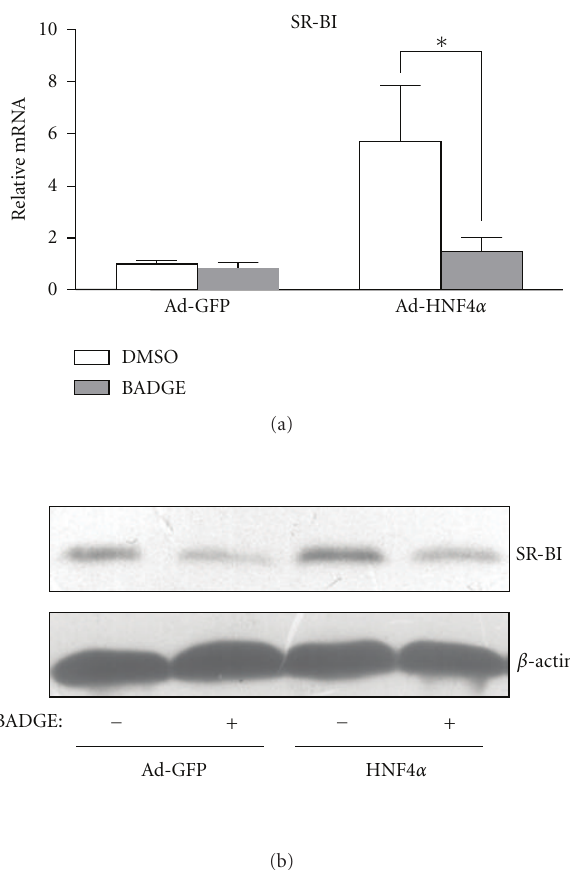
Figure 5: HNF4 α -upregulated SR-BI depends on PPAR γ . Rat pri- mary hepatocytes were pretreated with or without PPAR γ antago- nist BADGE (10 μ M) for 30 min and then infected with Ad-HNF4 α or Ad-GFP. (a) Real-time PCR analysis of mRNA expression and (b) western blot analysis of protein expression from 3 independent ex- periments. β -actin was used as an internal control. Data are mean ± SEM mRNA levels normalized to that of β -actin and expressed as fold of control group. ∗ P < 0 . 05, ∗∗ P < 0 .